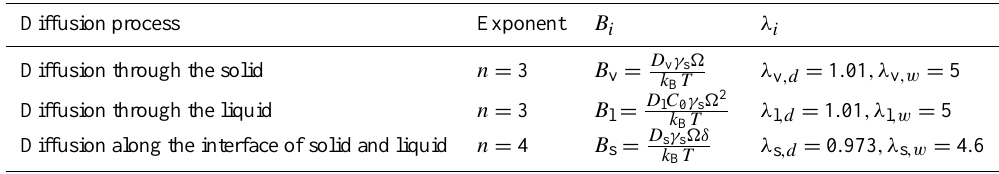
λ v ,d = 1 . 01 ,λ v ,w = 5 k B T 2 λ l ,d = 1 . 01 ,λ l ,w = 5 k B T λ s ,d = 0 . 973 ,λ s ,w = 4 . 6 k B T